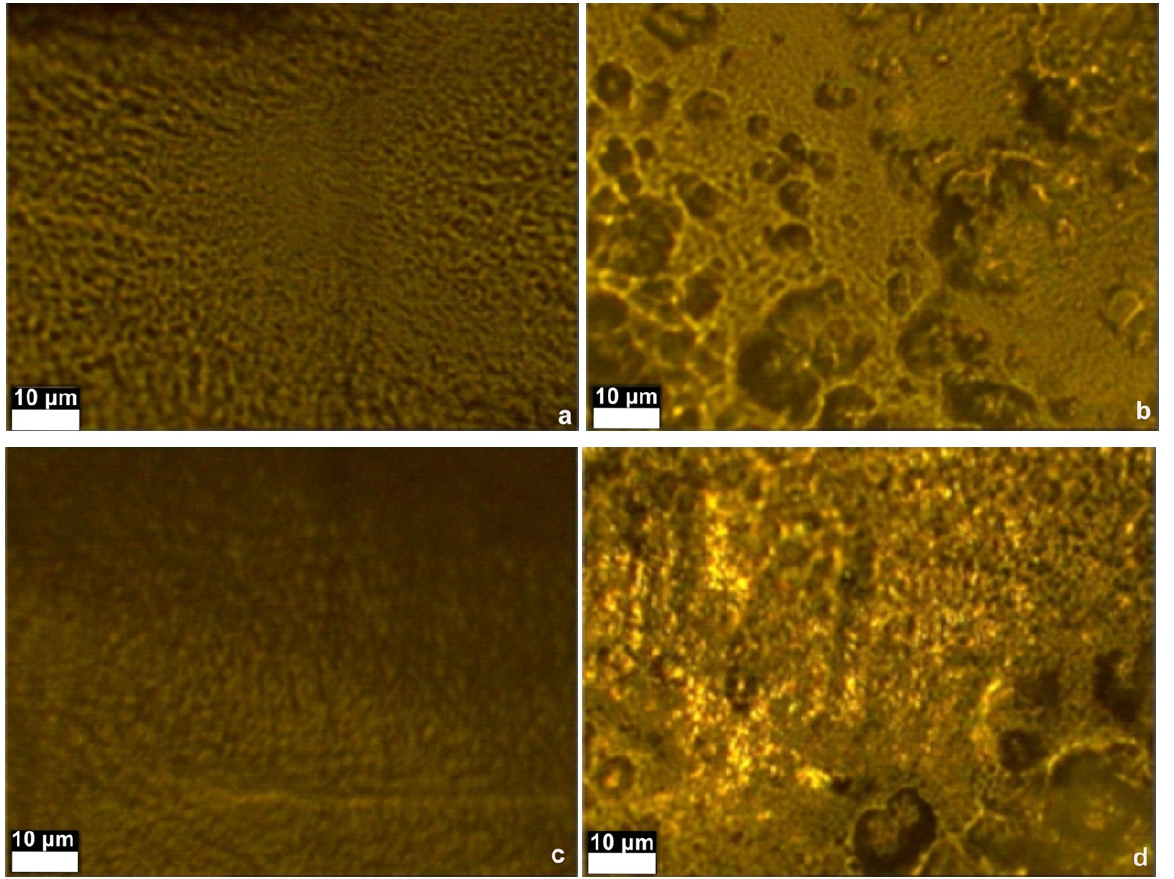
Figure 7. Images (50 × ) obtained for ( a ) CA sample, ( b ) CA-HAp sample, ( c ) CA-Mg sample, and ( d ) CA-HAp-Mg sample.